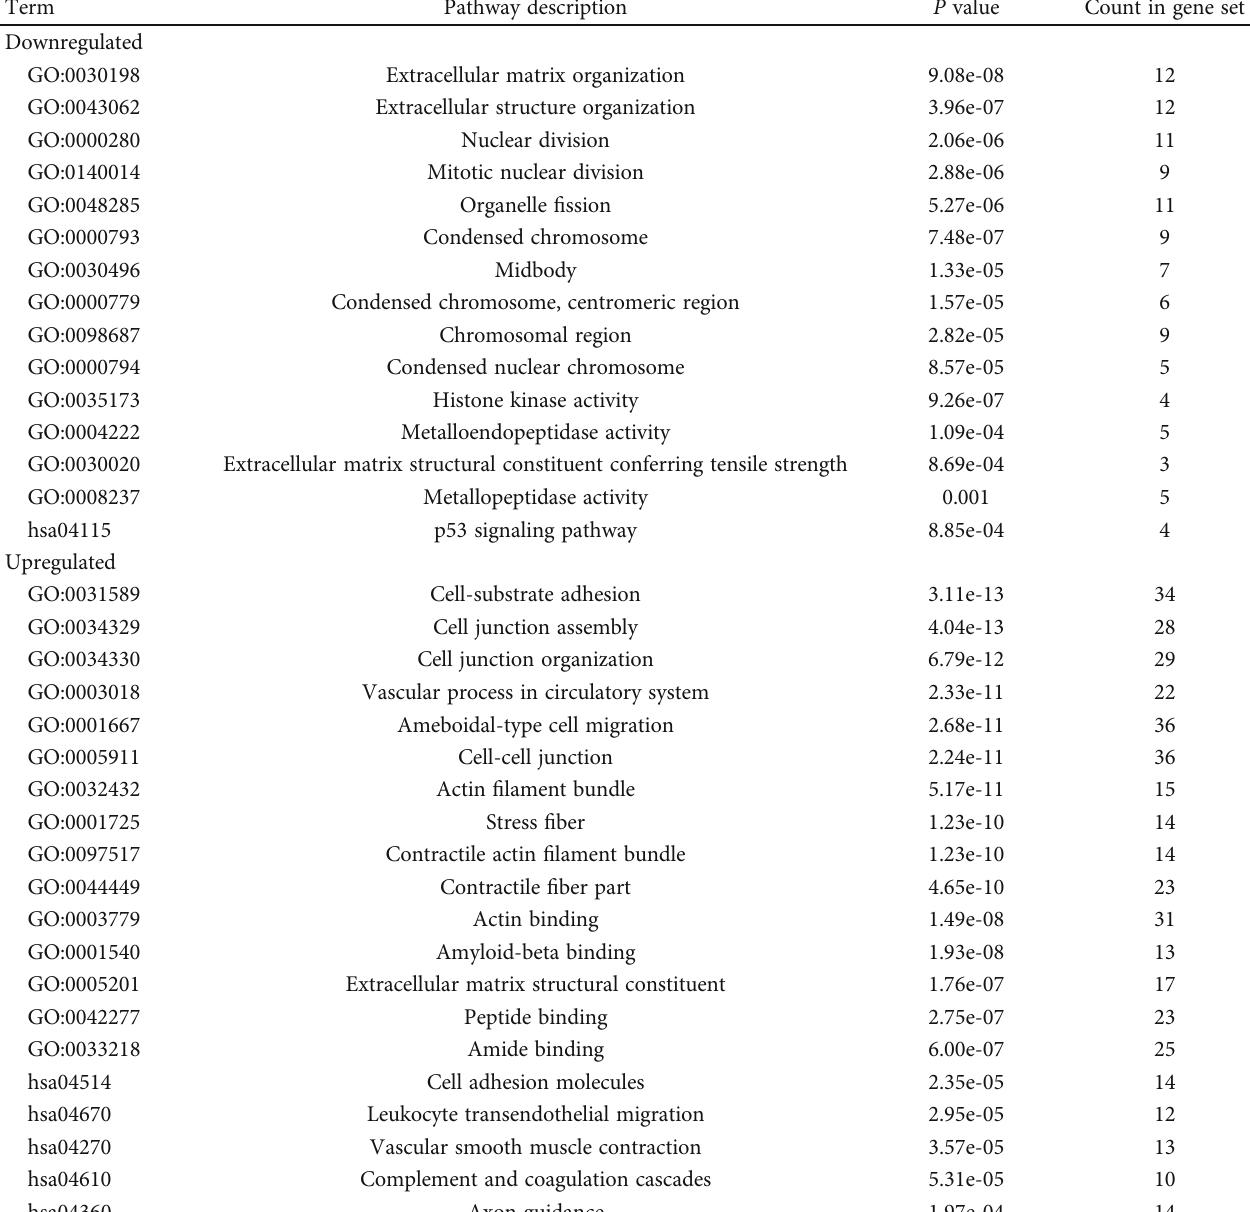
Table 1: GO and KEGG pathway enrichment analyses of DEGs in NSCLC